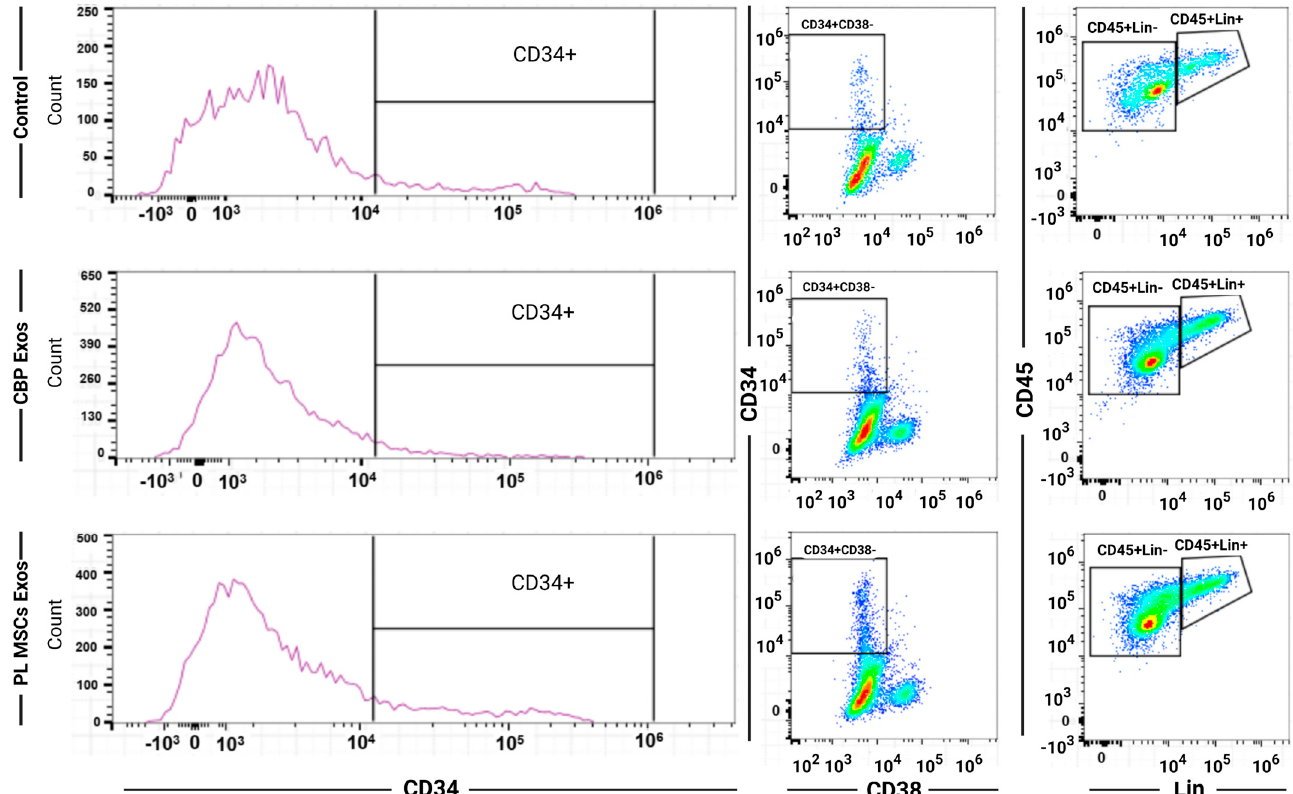
Figure 4. Representative flow cytometric dot blot diagrams of each subpopulation. CBP: cord blood plasma; PL MSCs: placenta mesenchymal stem cells. The effects of CBP and PL MSCs exosomes on the surface markers profile of the expanded CD34 + cells. CB CD34 + cells were maintained under three different culture conditions for 10 days ( n = 3, 3 replicates each). Flow cytometric analysis for surface markers CD34, CD38, CD45, and Lin (surface markers cocktail of differentiated cells) was done for day 10 expanded cells.